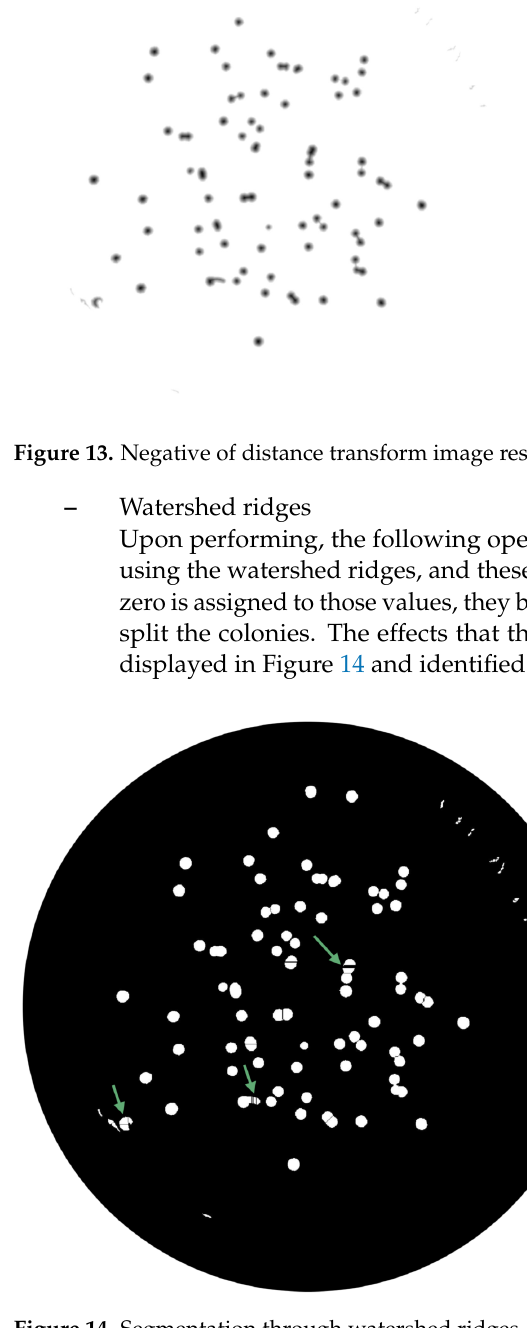
Figure 14. Segmentation through watershed